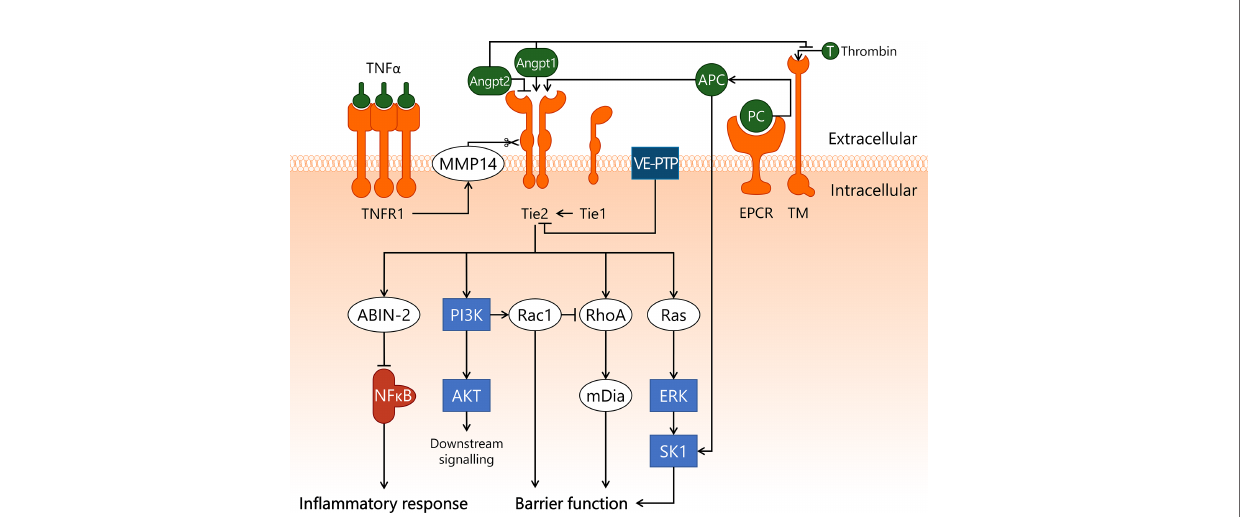
FIGURE 5 | Endothelial Angpt/Tie2 signalling is compromised in sepsis. A key regulator of endothelial homeostasis – Tie2 – is heavily modulated in sepsis, which can result in endothelial dysfunction. Angpt1 and APC serve as agonists for Tie2, whereas Angpt2 competitively binds to Tie2, preventing its activation. Angpt1 and Angpt2 can also bind to TM, hereby inhibiting EPCR/TM/thrombin-dependent conversion of PC to APC. Tie2 activity is further modulated through association with Tie1, which lowers the activation threshold of Tie2 to promote its activation, and VE-PTP, which decreases Tie2 activation status through dephosphorylation. TNF a / TNRF1 promotes cleavage of the extracellular domain of Tie2 via MMP14. Upon activation, Tie2 exerts an anti-in fl ammatory effect by activating ABIN-2, which prevents nuclear translocation of NF- k B. In addition, Tie2 activates Ras/ERK/SK1 and PI3K/AKT. Finally, Tie2 has a protective effect on endothelial barrier function through PI3K-dependent activation of Rac1, and RhoA-dependent activation of mDia. ABIN-2, A20-binding inhibitor of NF- k B activation-2; AKT, protein kinase B; Angpt1, angiopoietin-1; Angpt2, angiopoietin-2; APC, activated protein C; ERK, extracellular signal-regulated kinase; mDia, mammalian Diaphanous-related formin Dia; MMP14, matrix metalloproteinase-14; NF- k B, nuclear factor kappa-light-chain-enhancer of activated B cells; PI3K, phosphoinositide 3-kinase; Rac1, Ras-related C3 botulinum toxin substrate 1; Ras, Ras protein subfamily; RhoA, Ras homolog gene family, member A; SK1, sphingosine kinase 1; T, thrombin; Tie1, tunica intima endothelial kinase 1; Tie2, tunica intima endothelial kinase 2; TM, thrombomodulin; TNFR1, tumor necrosis factor alpha receptor 1; TNF a , tumor necrosis factor alpha; VE-PTP, vascular endothelial protein tyrosine